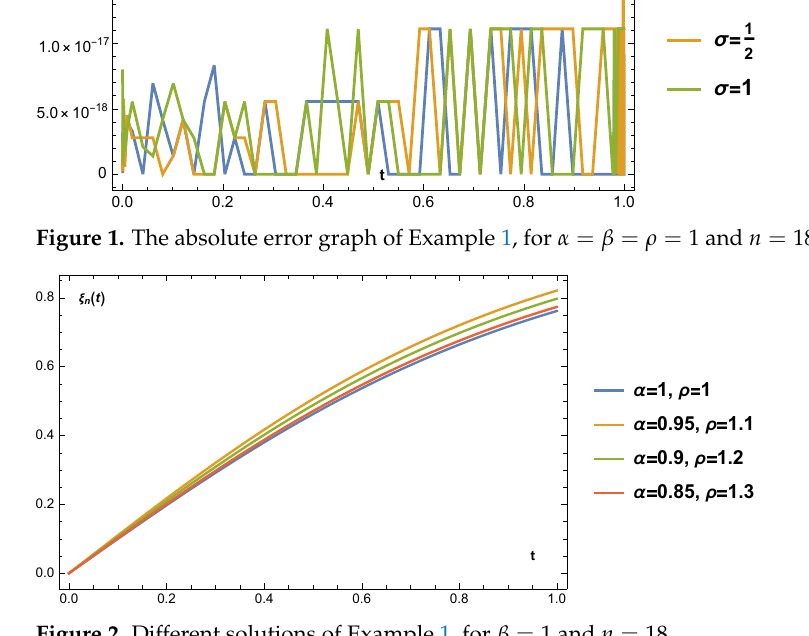
Figure 2. Different solutions of Example 1, for β = 1 and n =